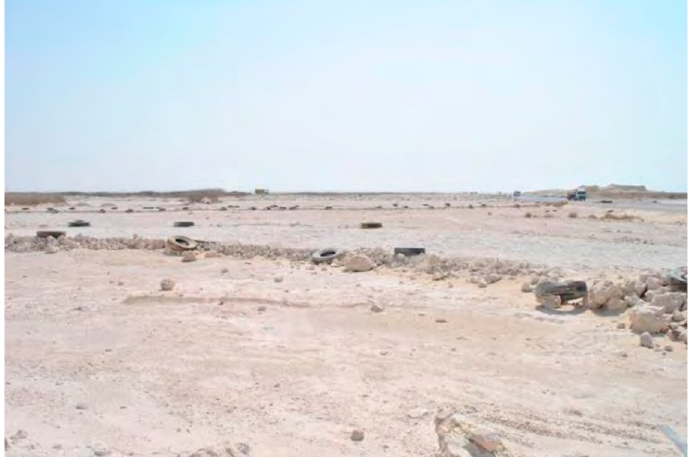
Figure 2. Disturbed limestone gravel plain by tire tracks and used tires as the typical landscape at the Karaana study site.